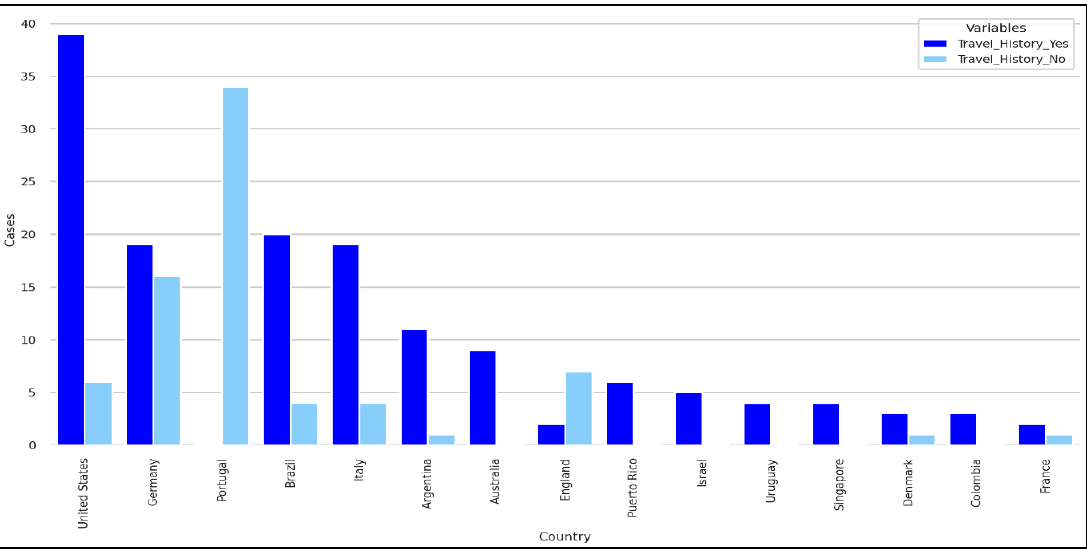
Figure 4. T ravel history based on Nationality. Figure 4. Travel history based on